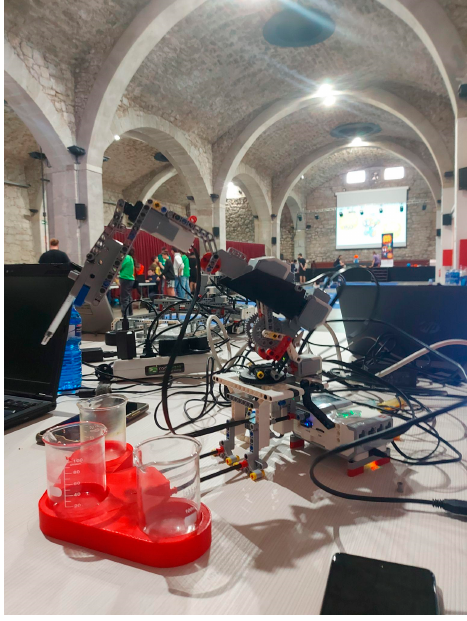
Figure 9. MultiArm Qui-Bot [32] with the syringe plunger for suctioning colored liquids in the 3D-designed pipette holder.